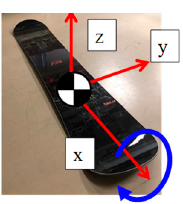
Figure 1. Coordinate system.